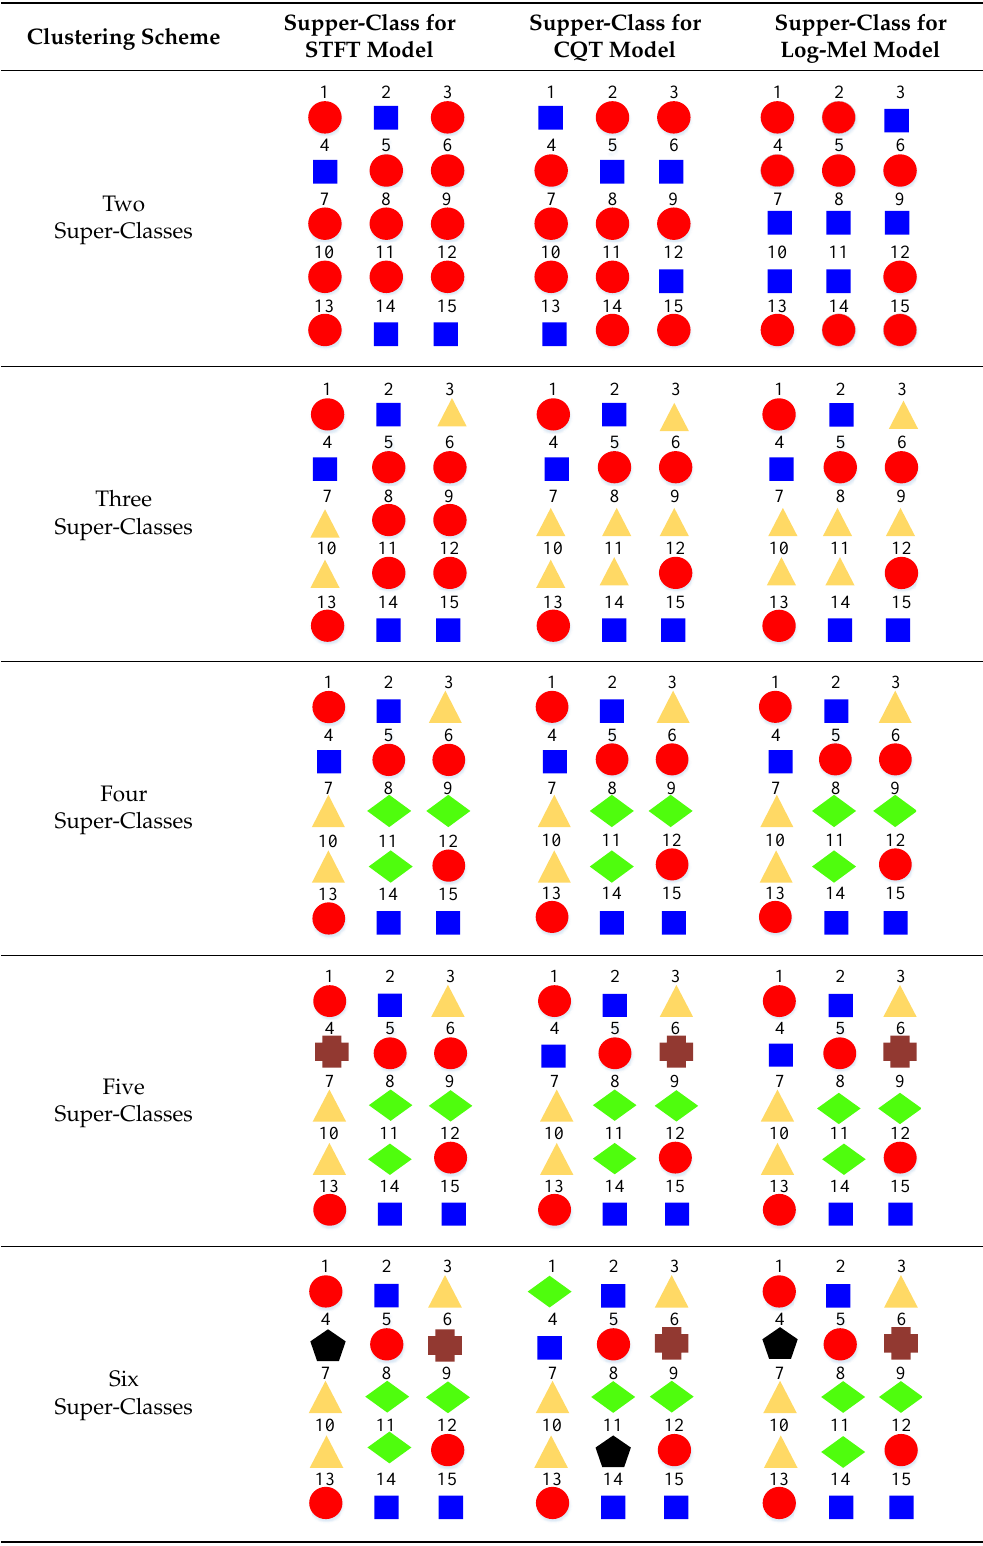
Table 2. Clustering details of the constructed super-class for the TUT Acoustic Scenes 2017 dataset. The classes marked by the same shape with the same color are grouped into the same super-class.